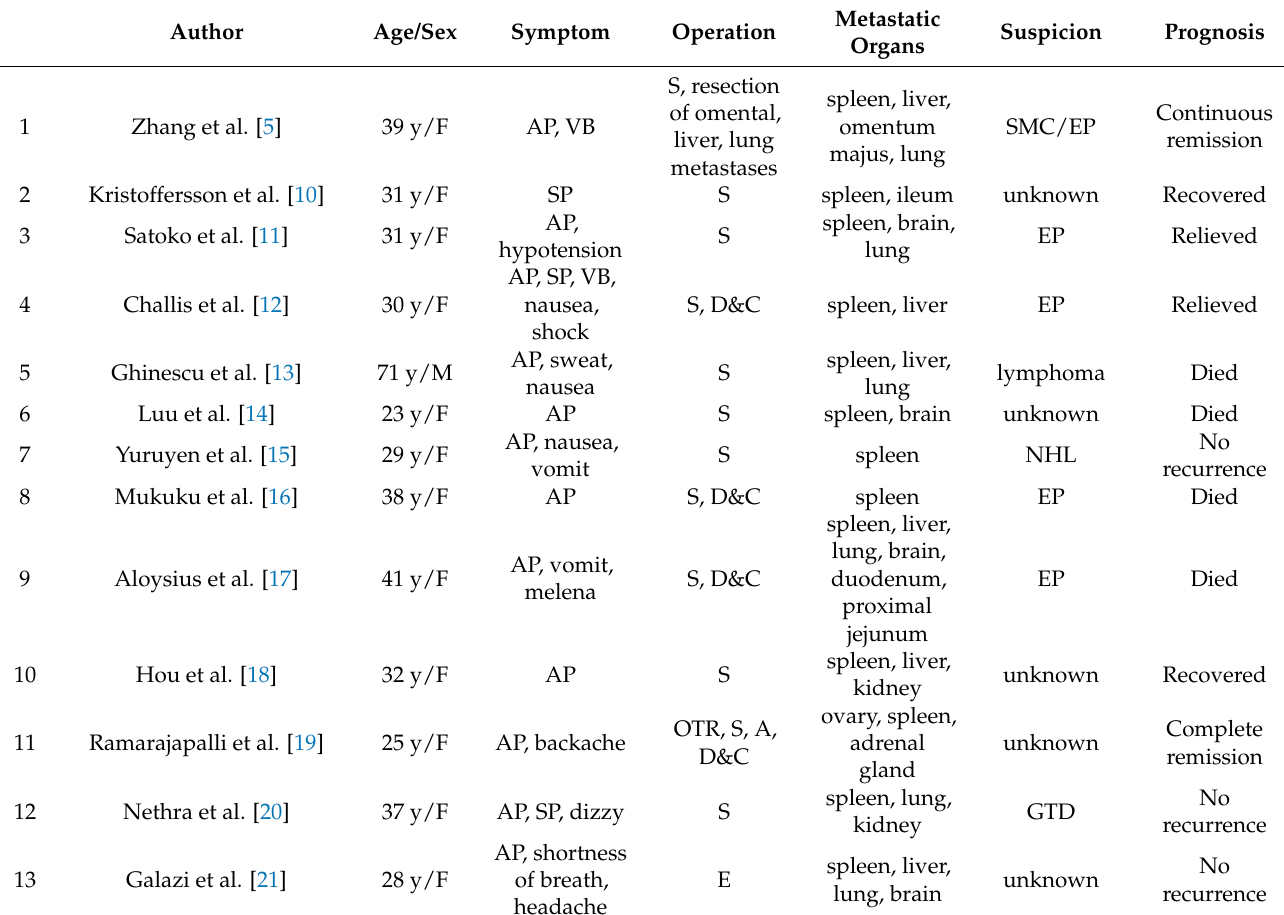
Table 3. Reported Cases of Splenic Metastatic